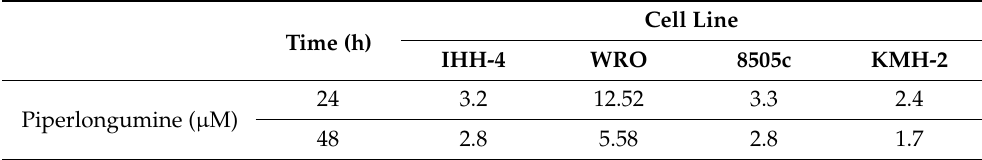
Table 1. IC 50 values of piperlongumine in human thyroid cancer cells.